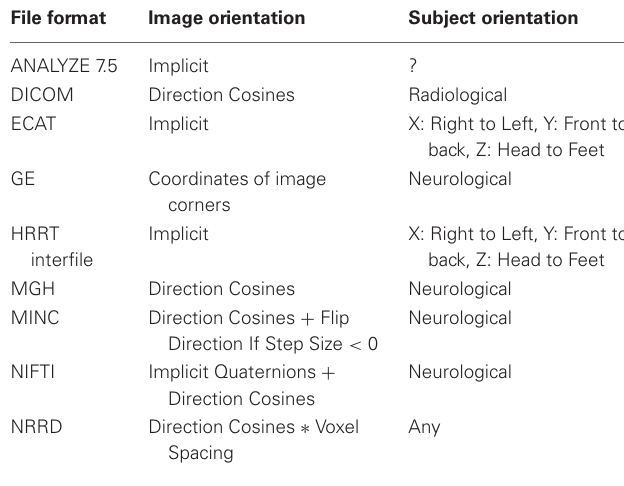
Table 1 | Comparison of how image and subject orientation information is captured in different neuroimaging file